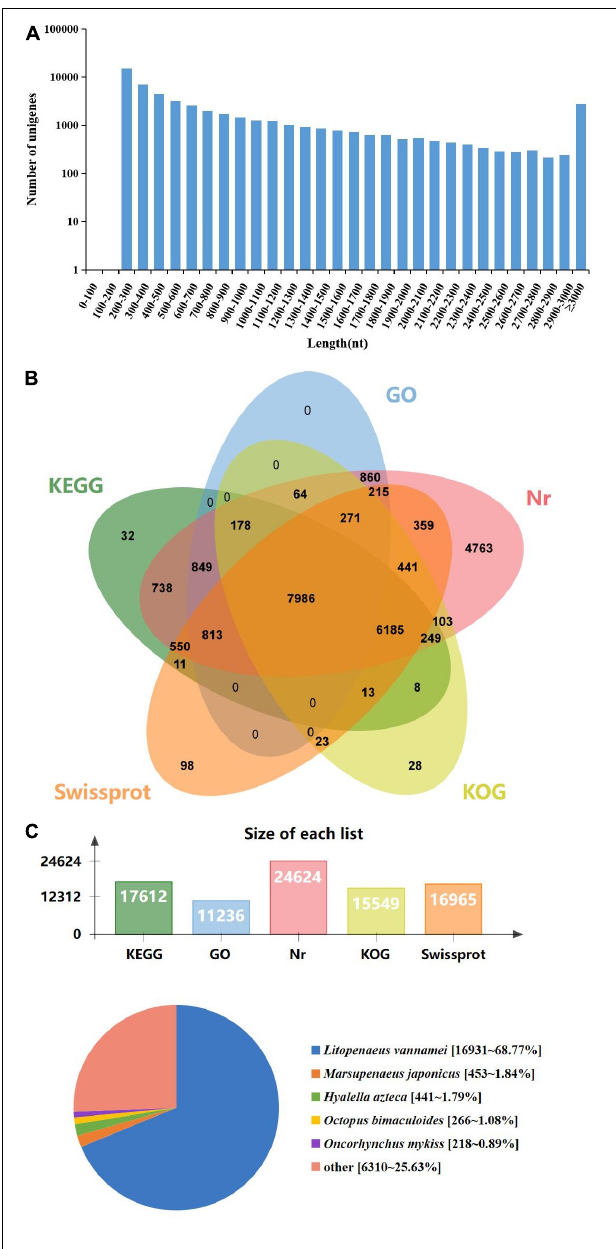
FIGURE 3 | Length distribution, annotation, and species distribution of transcriptome unigenes. (A) The X -axis indicates the length of the unigenes, while the Y -axis indicates the number of unigenes. (B) The Venn diagram shows the annotation of the unigenes from the Marsupenaeus japonicus transcriptome. (C) The species distribution of unigene BLASTx matches against the Nr protein database and the proportions for each species.